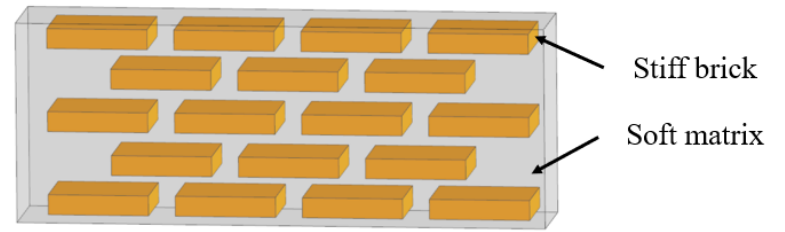
Figure 1. Schematic representation of the layered model.